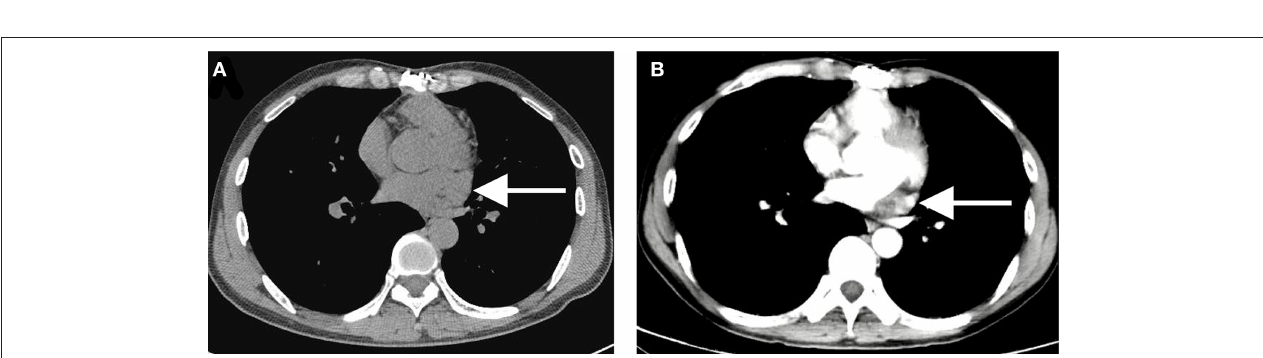
FIGURE 4 | A 2- (A) to 4-year (B) post-operative computed tomography showing no evidence of remnant lymphangiohemangioma progression with the same size of 10 × 15 × 30mm (arrow).